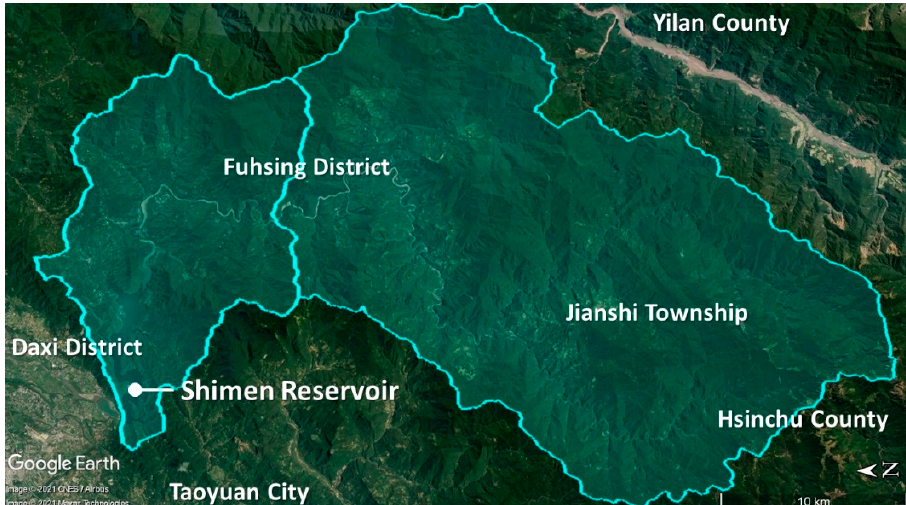
Figure 1. Location of Shimen Reservoir (including water catchment area).